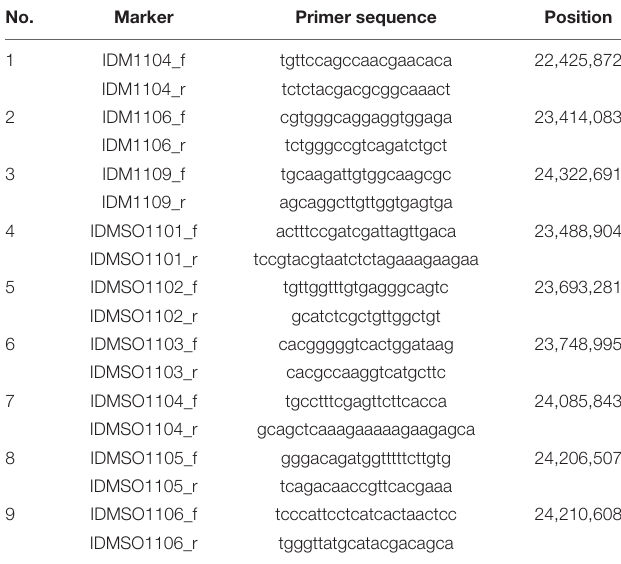
TABLE 2 | List of InDel markers for fine mapping of hwj2 locus.